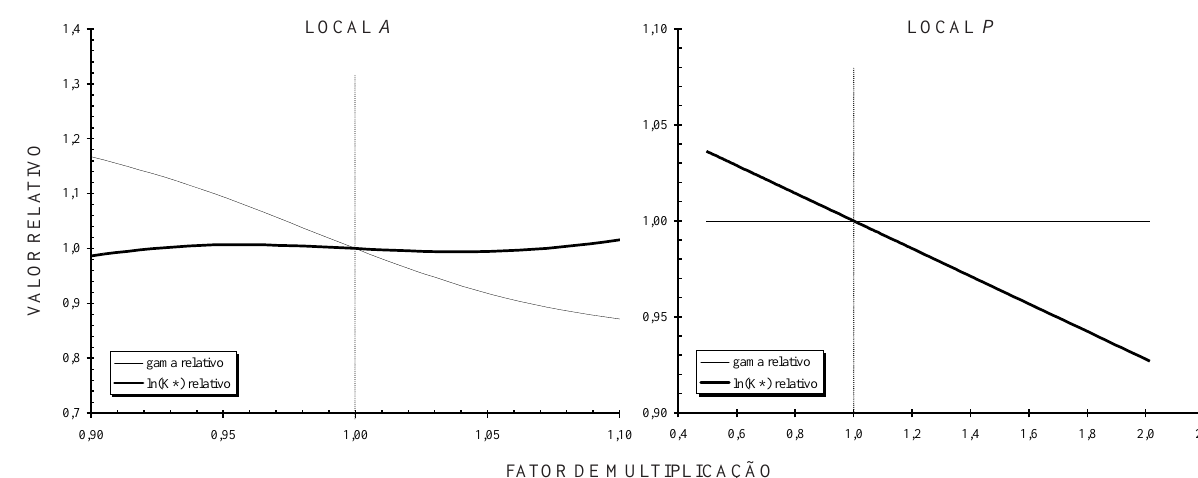
Figura 8. Valores de ggggg e ln(K * ) para o local A (0,20 m) e local P (0,30-0,45 m), obtidos da indução de um erro nos interceptos das curvas de calibração do TDR de todas as profundidades, multiplicando-os pelo fator na abscissa, relativos, respectivamente, aos valores de ggggg de